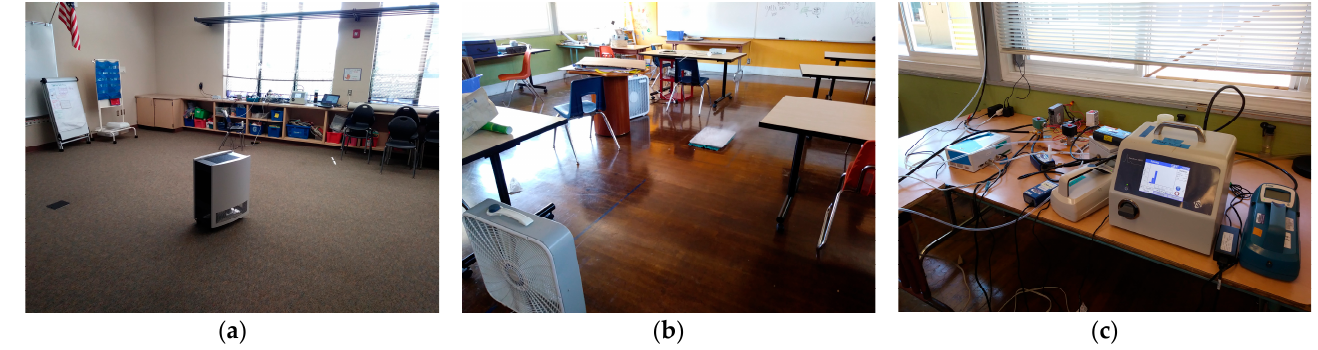
Figure 2. Instrument arrangement for indoor/outdoor air sampling. ( a ) Portable air cleaner placement in the center of unoccupied classroom. ( b ) Air exchange CO 2 experiment. ( c ) Sampling instruments.